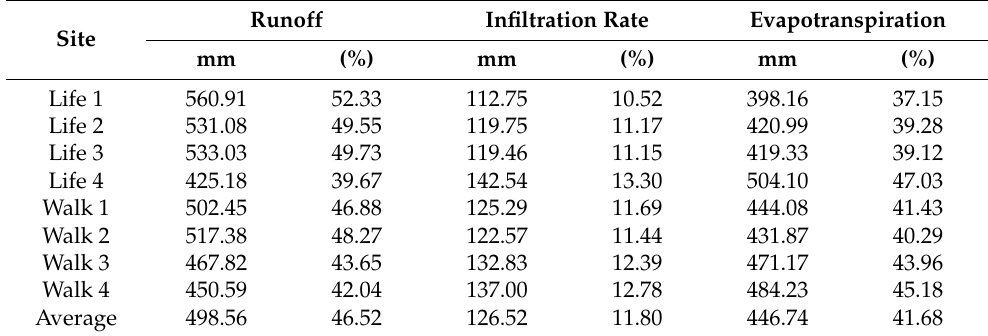
Table 6. Results of evaluating the water balance analysis of the study sites.